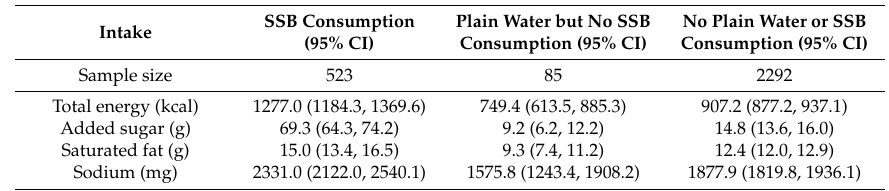
Table 2. Daily energy and nutrient intake at full-service restaurant by plain water and sugar-sweetened beverage (SSB) consumption status, 2005–2012 NHANES.